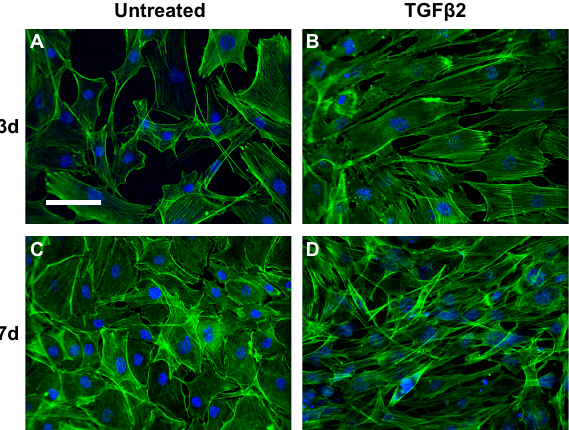
Figure 6. Representative images (20X) of untreated MSCs and MSCs treated with TGF β 2. The actin cytoskeleton (green) and cell nuclei (blue) are shown at 3 and 7 days. ( A ) Untreated cells at day 3 and ( C ) day 7 display typical MSC morphology. ( B ) Cells treated with 50 ng/mL TGF β 2 show increased elongation and proliferation at day 3, and ( D ) these changes become more pronounced at day 7. Scale bar = 100 μ m.